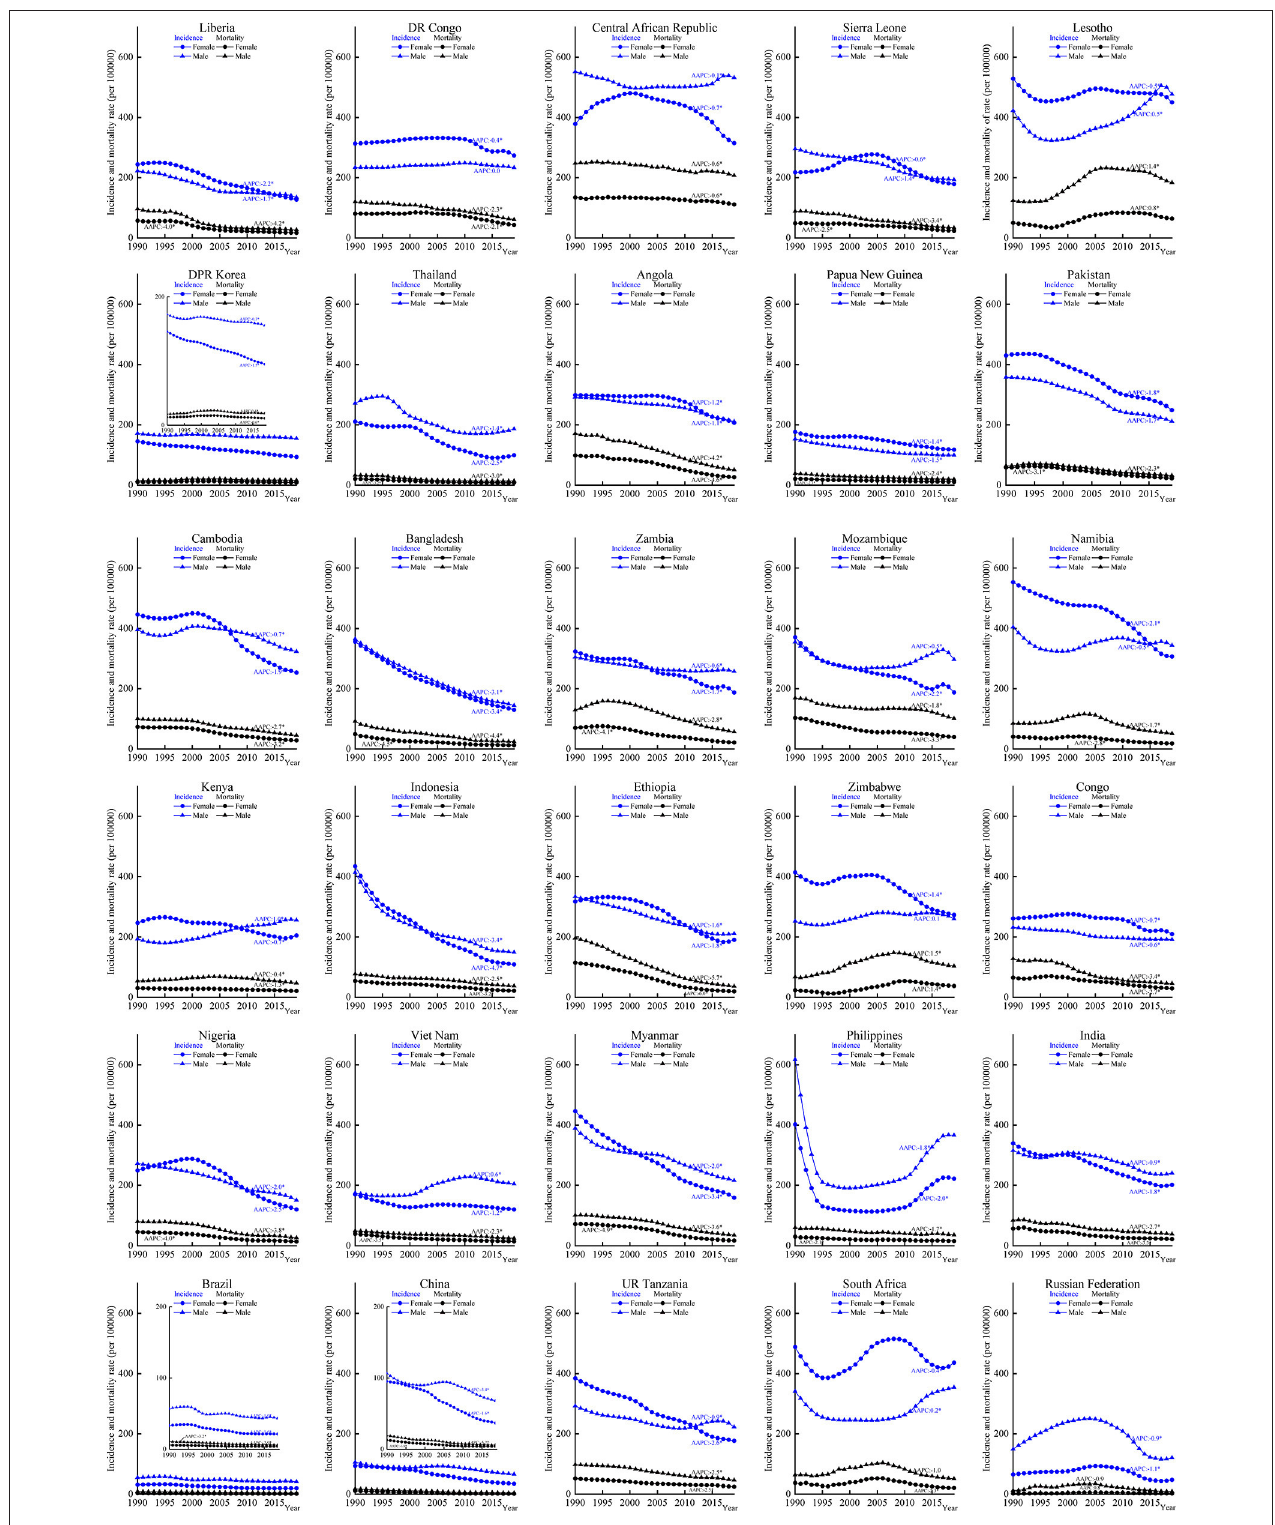
FIGURE 2 | Incidence and mortality of tuberculosis (TB) by different sexes in the 30 HBCs, 1990–2019. HBC, high burden country; AAPC, average annual percent change; *, significant at 0.05 level.